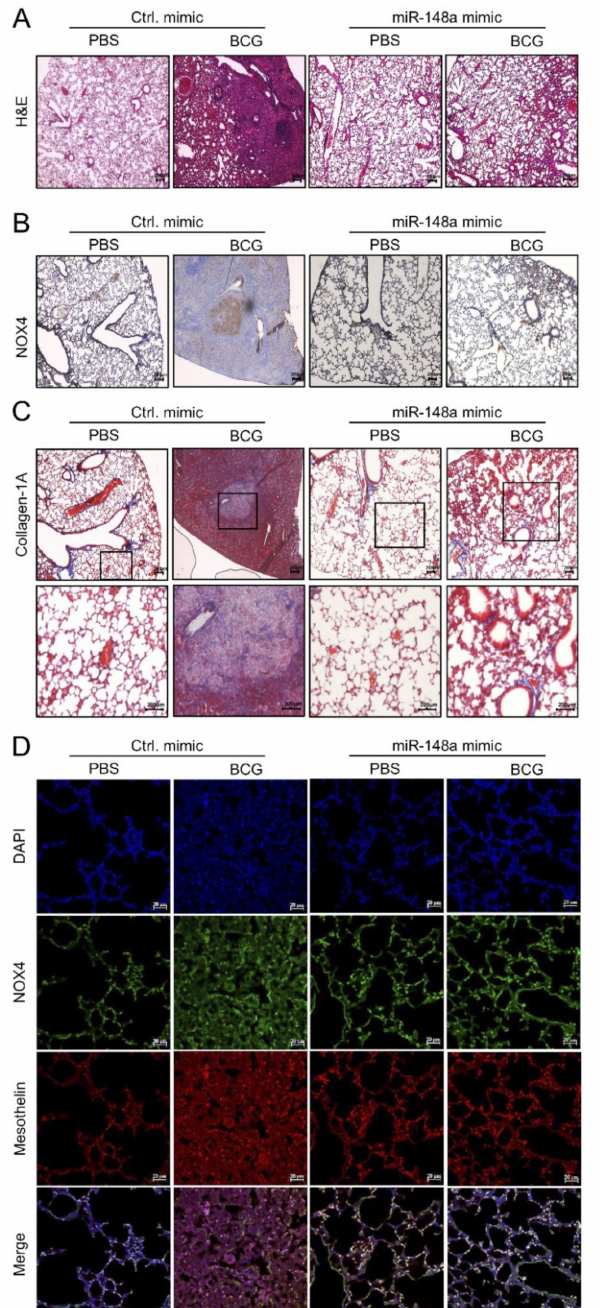
Figure 6. miR-148a posttreatment regulates NOX4 expression and inhibits collagen-1A infiltrates in mouse lungs. ( A ) H&E staining, × 100 ( B ) Immunostaining of NOX4, × 100 ( C ) Masson Trichrome staining in mouse lung. × 100, × 200 ( D ) Immunofluorescence staining of NOX4 and mesothelin (markers for mesothelial cells). × 400 Light yellow areas represent colocalization of NOX4 (green) and mesothelin (red). DAPI,4 (cid:48) ,6-Diamidino-2-phenylindole